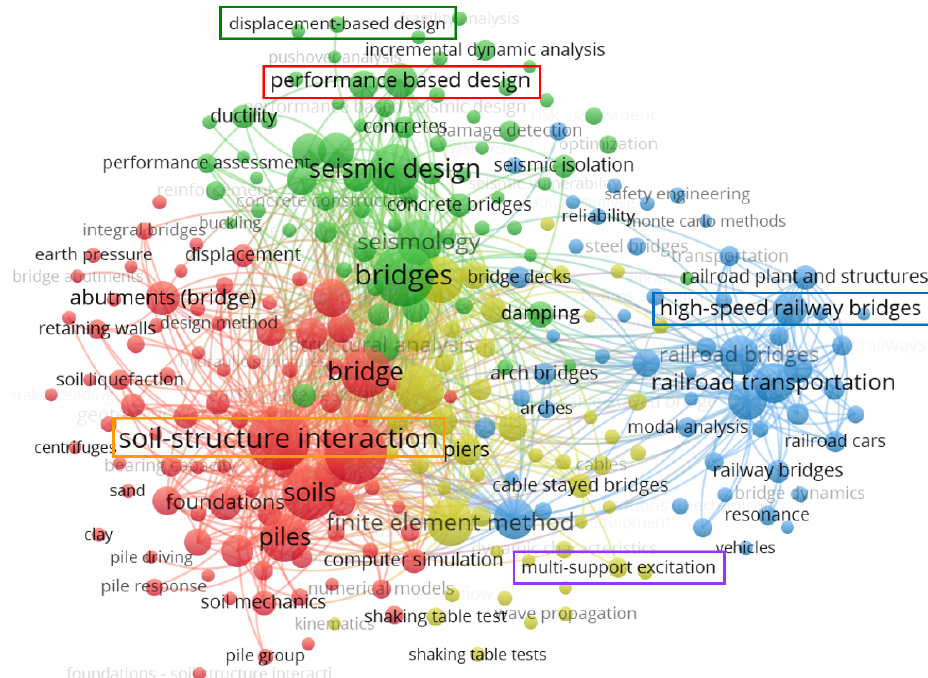
Figure 6. Bibliometric map of published research for bridge design.